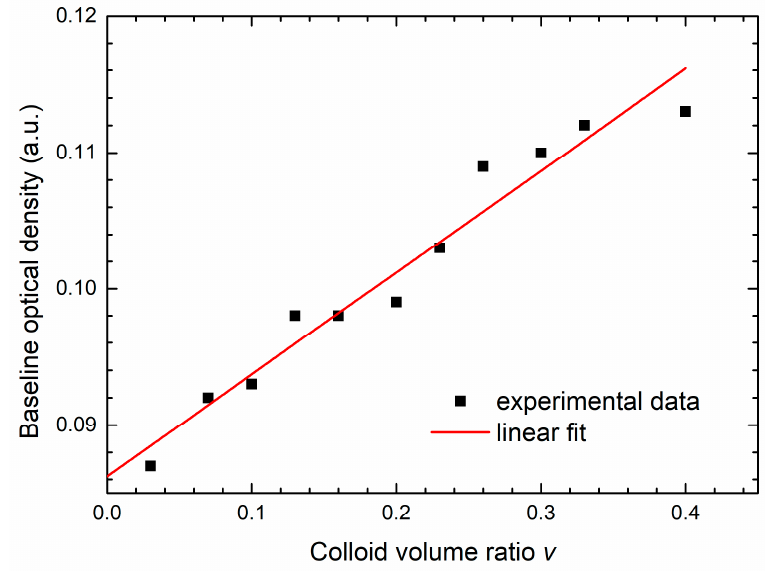
Figure 6. Initial OD (baseline) of the experimental growth curves given in Figure 2a, as a function of the colloid volume share v, is given by squares. Linear fit obtained for these data, given by the straight line, is the contribution of the silver nanoparticles to the total OD.